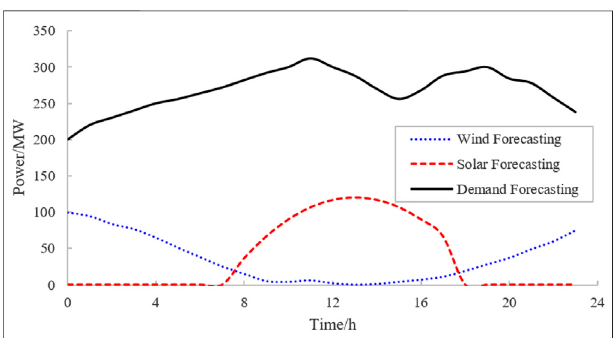
FIGURE 5 | Forecast Variation of Renewable Power and load